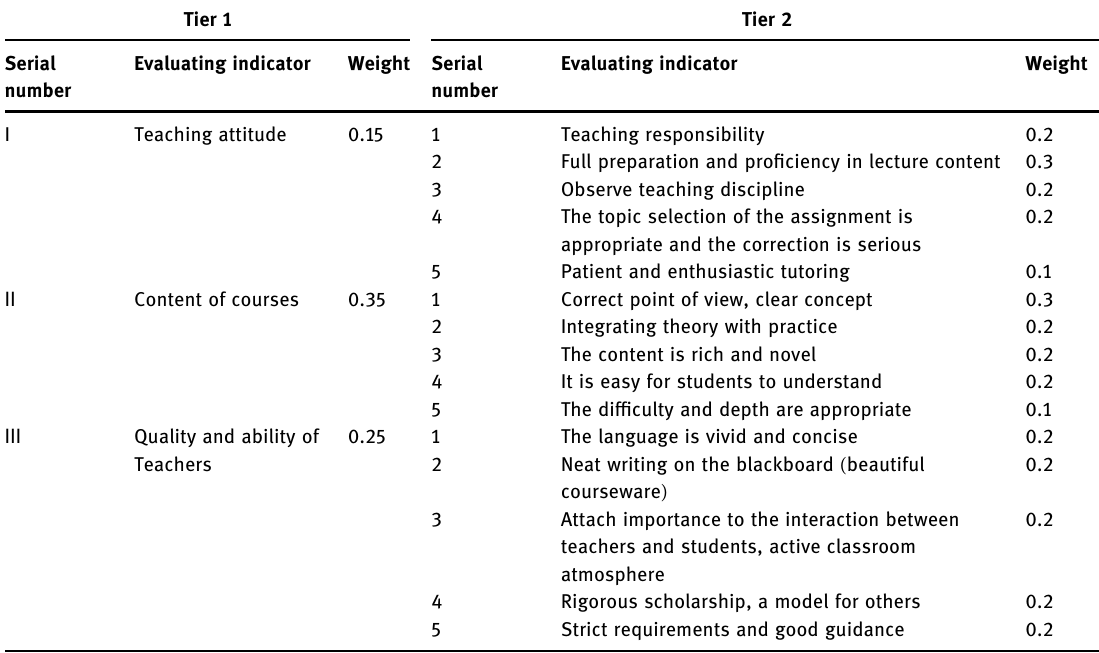
Table 4: Indicators and weights of students ’ evaluation of teaching